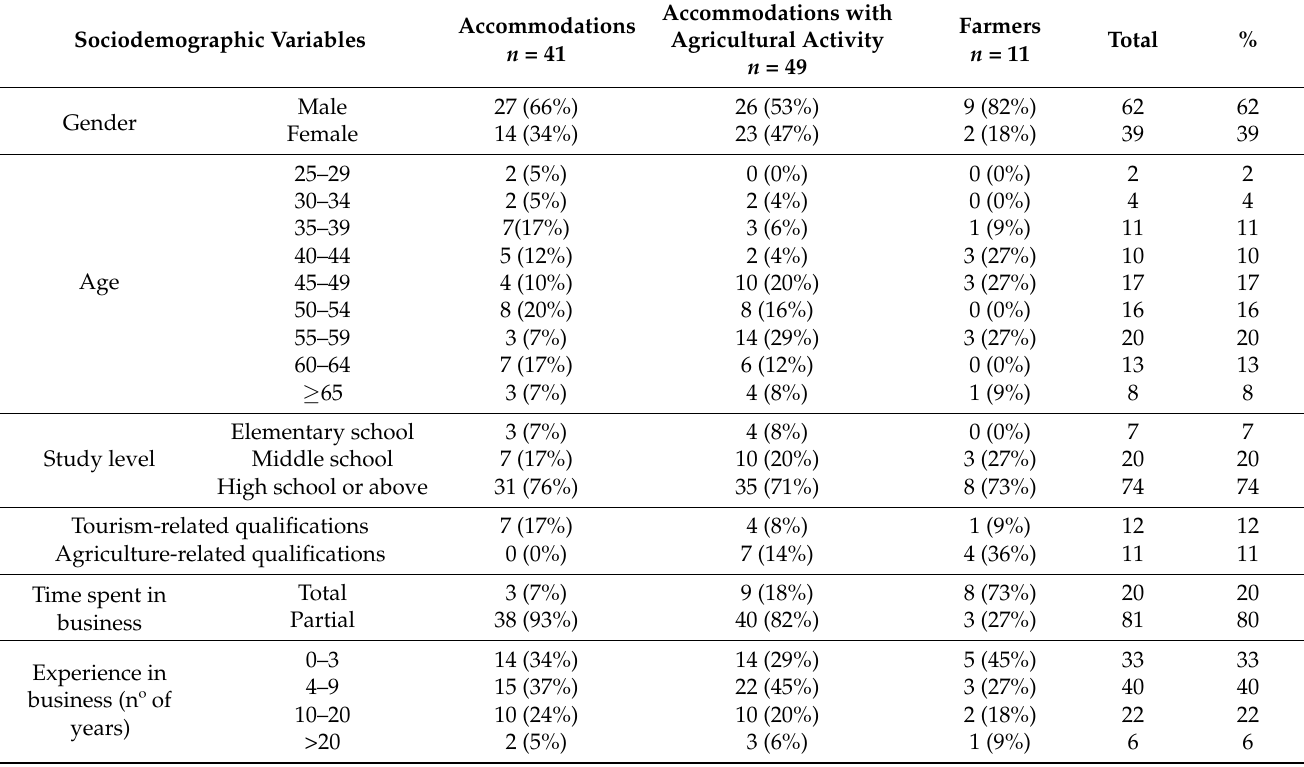
Table 2. Profile of